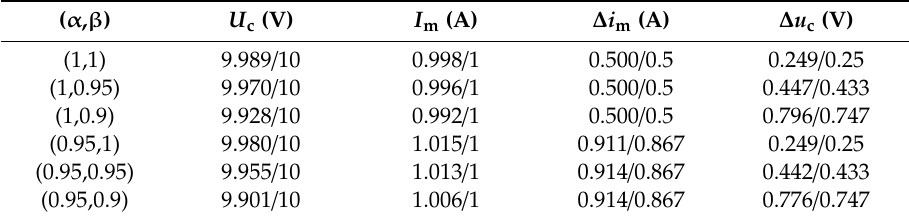
Figure 10. The circuit simulation and numerical calculation results under di ff erent α and β . ( a ) ( α , β ) = (1,1); ( b ) ( α , β ) = (1,0.95); ( c ) ( α , β ) = (1,0.9); ( d ) ( α , β ) = (0.95,1); ( e ) ( α , β ) = (0.95,0.95); and ( f ) ( α , β ) = (0.95,0.9). Table 3. The comparison between the circuit simulation and the theoretical